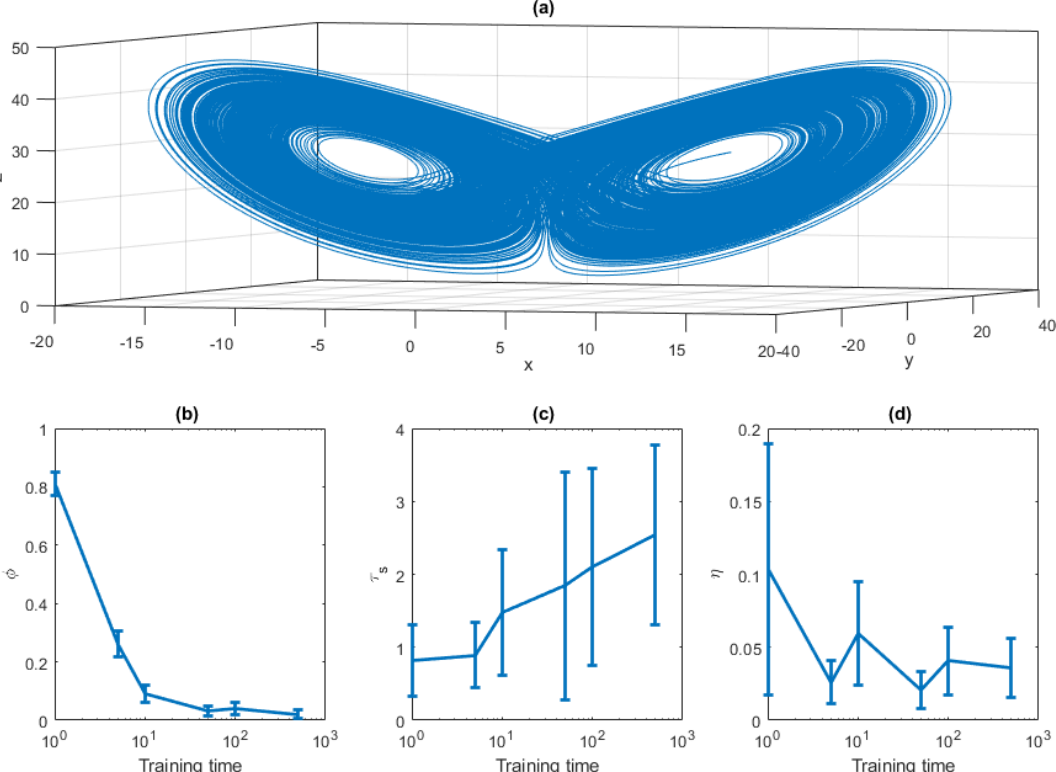
Figure 1. (a) Lorenz 1963 attractor obtained with an Euler scheme with d t = 0 . 001, σ = 10, r = 28 and b = 8 / 3. Panels (b) – (d) show the performance indicator as a function of the training time. (b) The rejection rate φ of the invariant density test for the x variable; (c) the first time t such that APE > 1; (d) the initial error η . The error bar represents the average and the standard deviation of the mean over 100